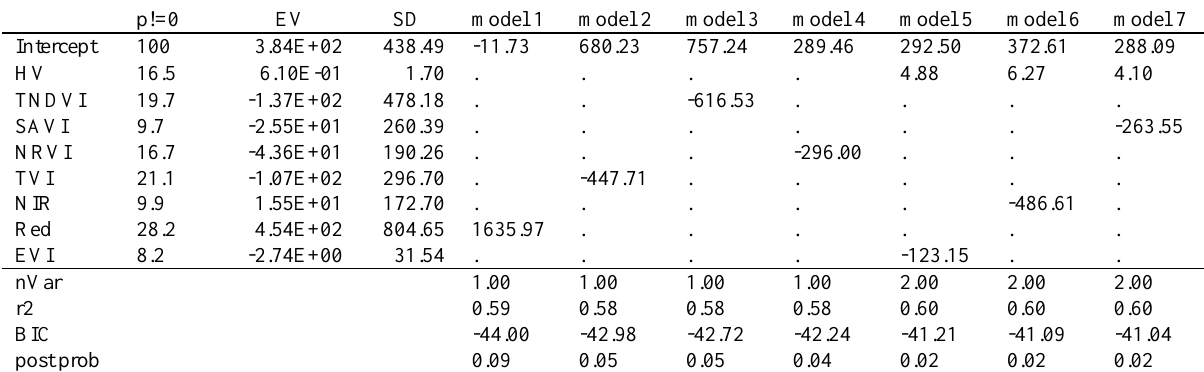
Figure 3. Linear regression between aboveground biomass and Landsat reflectance in Green, Red, and NIR (left panel); Vegetation indices in TNDVI and NRVI (middle panel); and PALSAR-2 backscattering in HH and HV (right panel). Table 2. The result of selecting the best fit model using Bayesian model